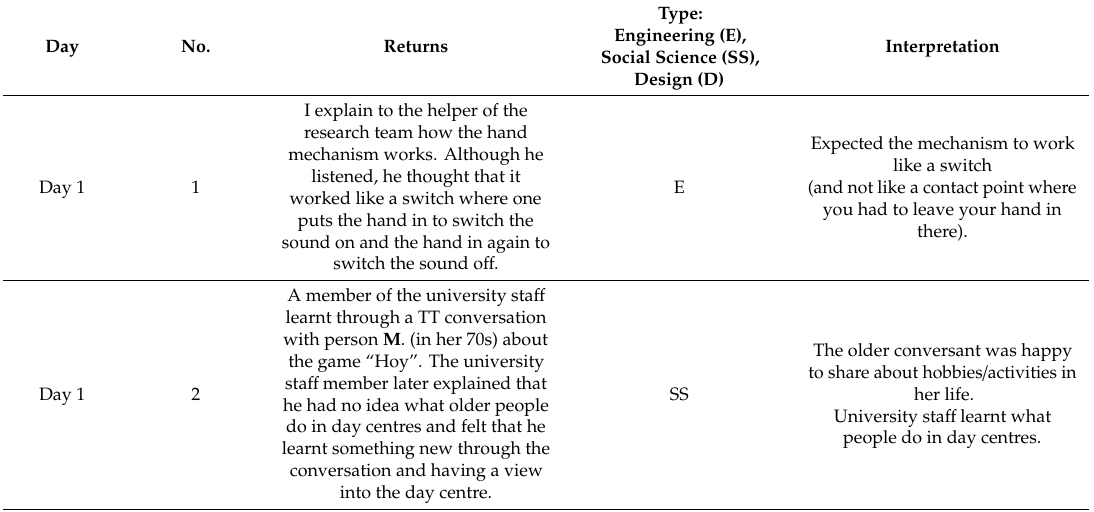
Table A1. Returns from the first in-the-wild